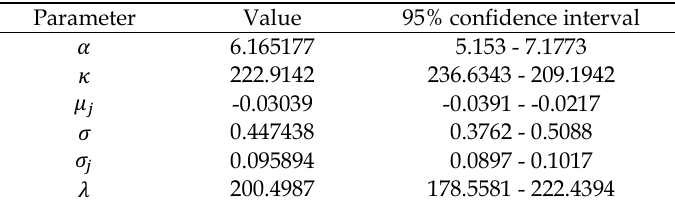
Table B2. Parameters of Stochastic Equation